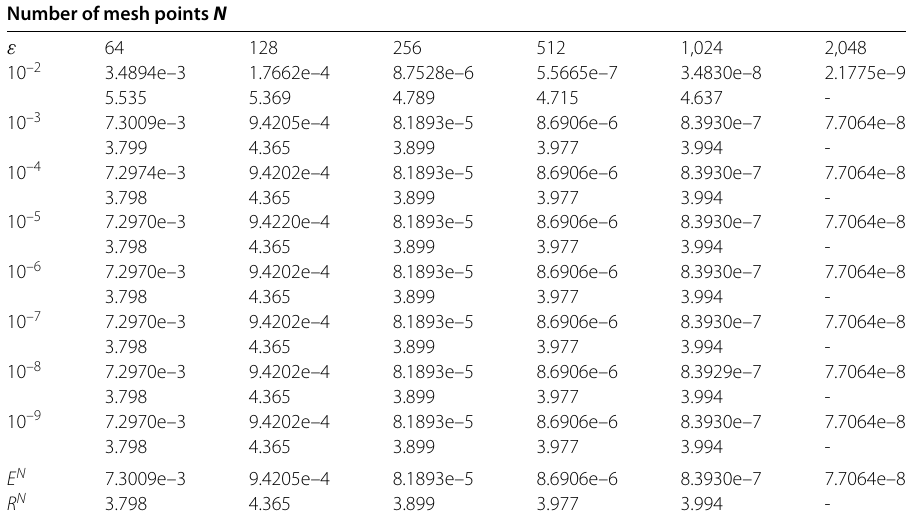
Table 1 Error estimates and convergence rates for various N for Example 5.1 Number of mesh points